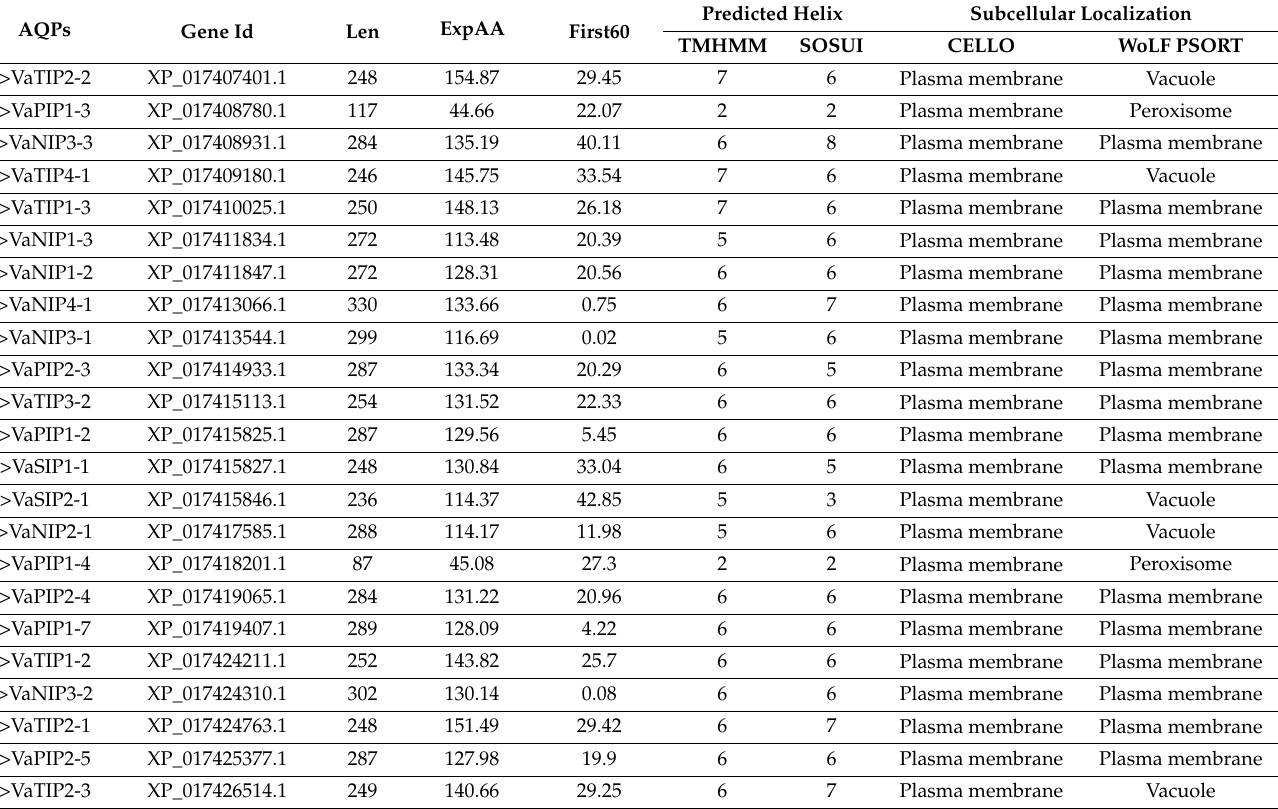
Table 1. Details of the transmembrane helix predicted by TMHMM and SOSUI and subcellular localization predicted by CELLO and WoLF